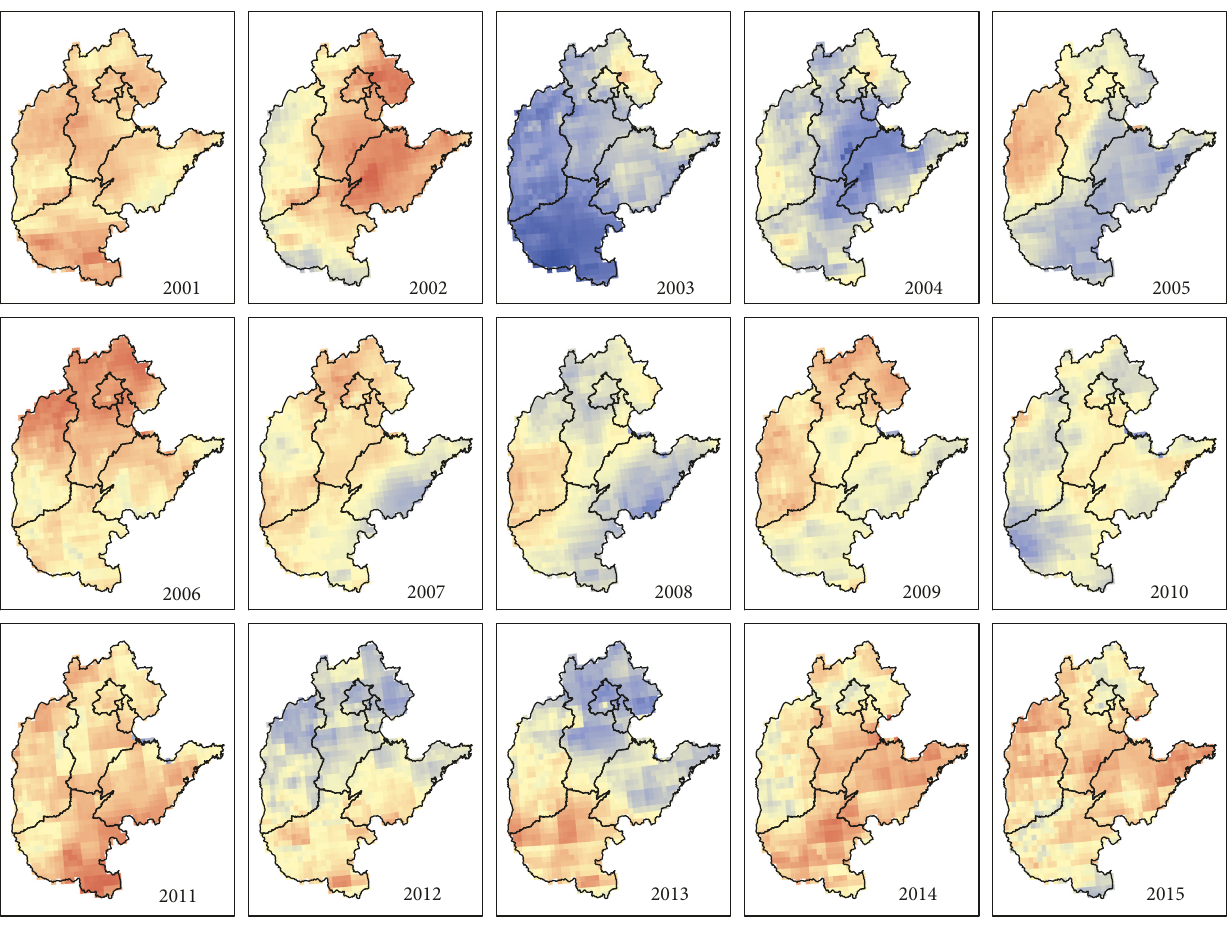
Figure 3: Spatial distribution of annual SMAI-1 in North China during